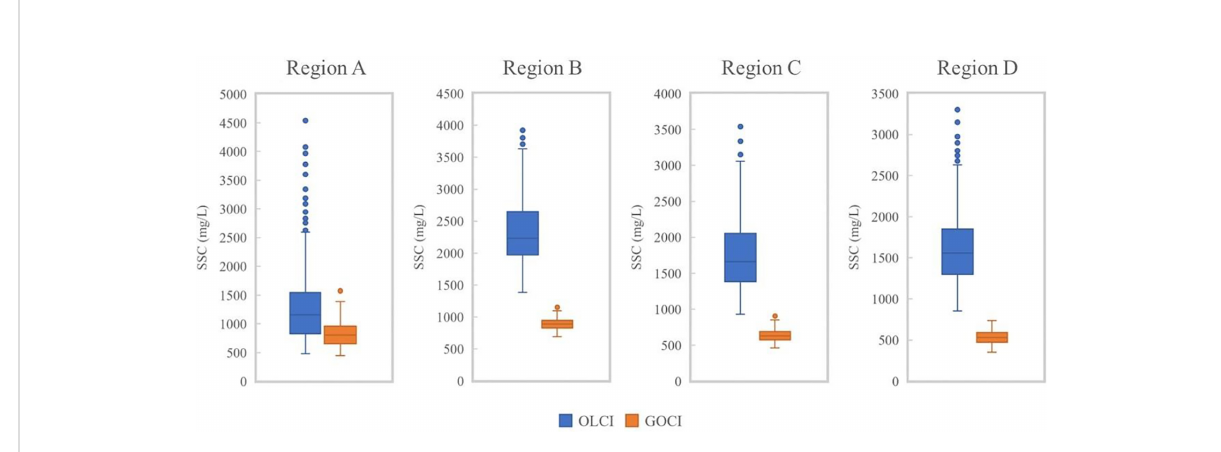
FIGURE 13 Box line plots of SSC in four experimental regions based on 2020